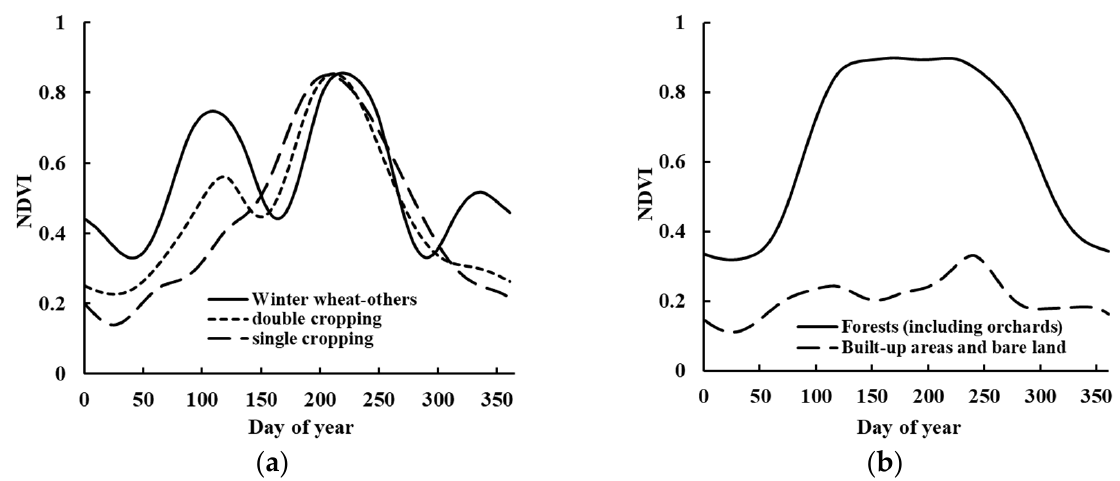
Figure 6. Time-series NDVI curves for (a) crop and (b) non-crop lands. The identified wheat-growing regions in Henan Province in 2018 are shown in Figure 1; these regions were aggregated at the municipal and county levels by counting the number of wheat pixels for each of the 18 municipalities and 80 counties. The calculated wheat areas were compared with the statistics to evaluate the accuracy of wheat identification, as shown in Figure 7. The linear correlations between the estimated wheat areas from the MODIS NDVI and the statistical areas were significant at both the municipal ( R 2 = 0.92 and p < 0.001) and county ( R 2 = 0.84 and p < 0.001) levels, with MRE values of 17.42% and 26.18% and RMSE values of 961.09 and 185.12 km 2 , respectively. Thus, the accuracy of wheat identification based on the time-series MODIS NDVI and LSTM model was high, which demonstrated that the LSTM model has an inherent advantage in capturing potential phenological information contained in time series of satellite observations for crop